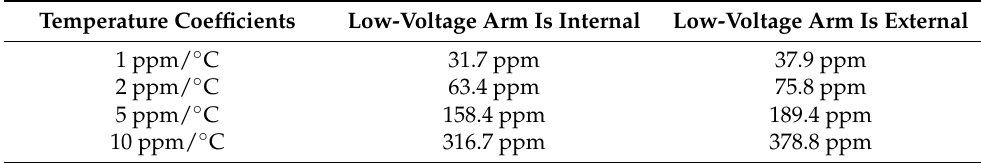
Table 3. Potential errors under different temperature